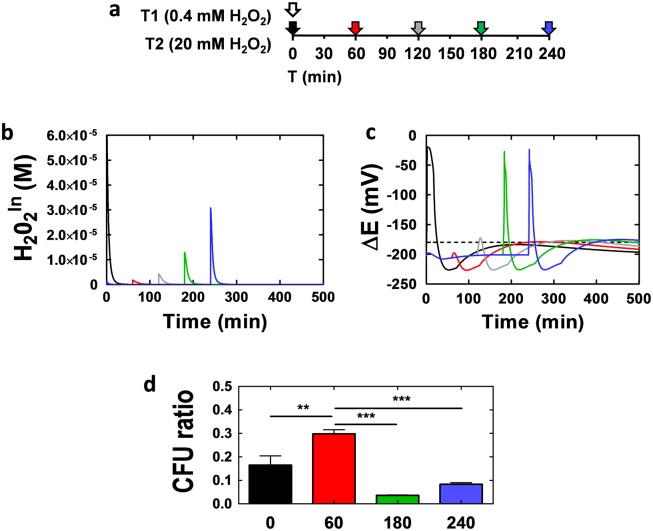
The model accurately predicts the temporal protection provided by oxidative stress adaptation.
(a) Representation of the timing of the sequential stresses applied in the experiment. The white arrow represents the initial 0.4mM mM H2O2 stress (T1), whilst the colored arrows represent the addition of the second 20 mM H2O2 stress (T2) at the following times after the first stress: 0 min (black arrow); 60 min (red arrow); 120 min (grey arrow); 180 min (green arrow); 240 min (blue arrow). (b) The predicted dynamics of intracellular H2O2 levels (H2O2
In), and (c) redox potential (ΔE) after imposition of the second 20 mM H2O2 stress at: 0 min (black); 60 min (red); 180 min (green); 240 min (blue). (d) Experimentally measured survival of C. albicans cells after exposure to the sequential stresses when T2 was: 0 min (black); 60 min (red); 180 min (green); 240 min (blue). Colony forming units (CFU) for stressed cells were measured relative to the untreated control cells. The data represent mean and standard deviation values from three independent experiments: *, P<0.05; **, P<0.01.